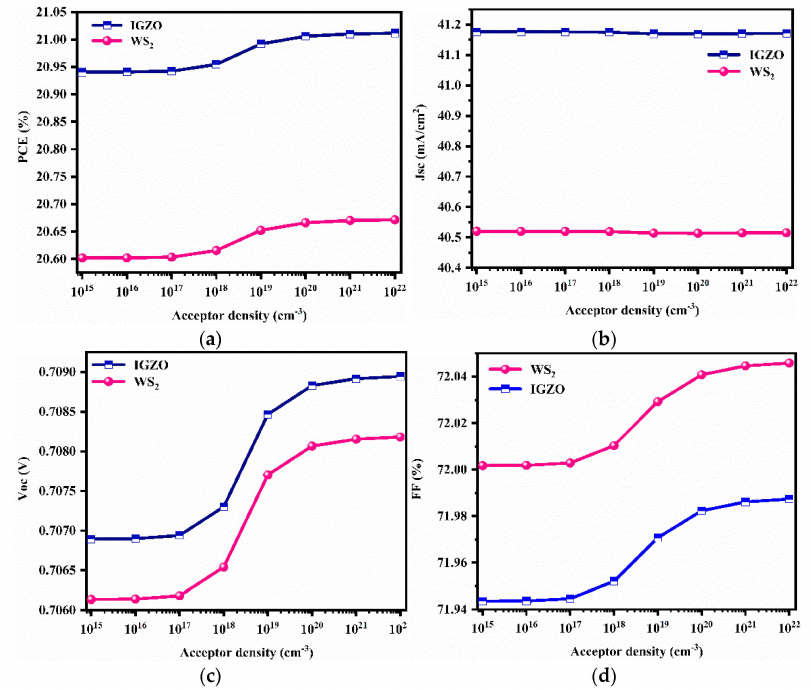
Figure 5. ( a – d ): Influence of variation in acceptor density (HTL Layer) on P-V parameters ( a ) PCE, ( b ) Jsc, ( c ) Voc, and ( d ) FF for WS 2 ETL- and IGZO ETL-based